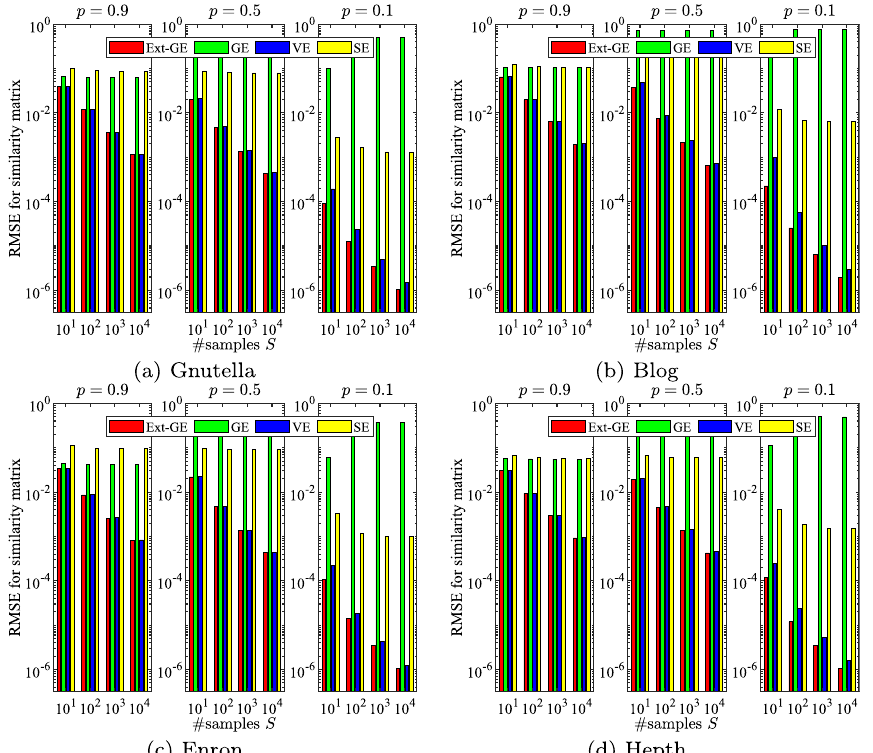
Fig. 6 RMSE of ensembled similarity matrix ¯ C against true similarity matrix